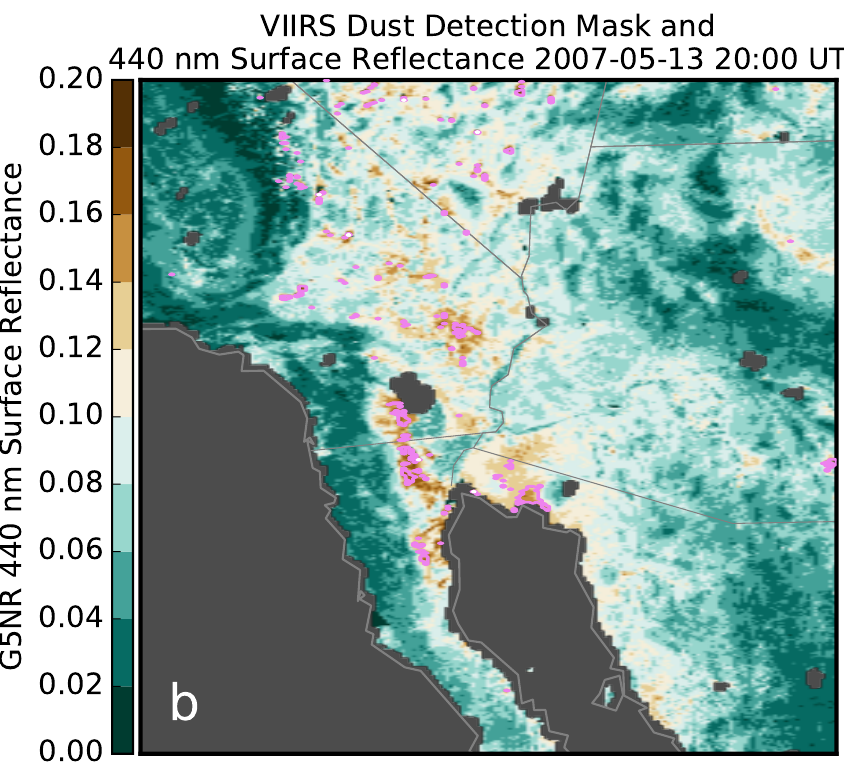
Figure 18. ( a ) Ratio of simulated 412 nm to 440 nm surface reflectance, and ( b ) simulated 440 nm surface reflectance for 13 May 2007 at 20 UTC. The black and purple contours represent the areas that were detected as smoke by the VIIRS aerosol detection